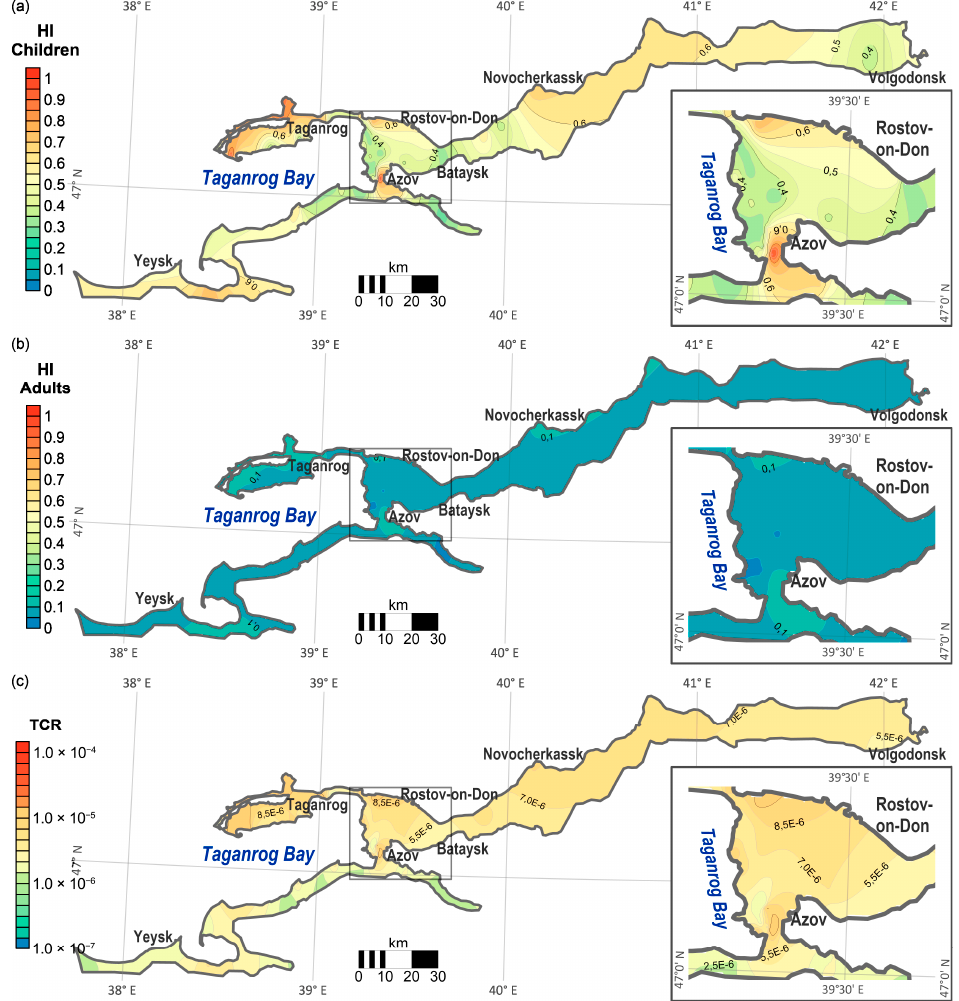
Figure 6. Spatial distribution of human health risk indices for PTEs and PAHs in topsoils of the Lower Don floodplain and the Taganrog Bay coast: ( a ) Total hazard index for children (HI_Children); ( b ) Total hazard index for adults (HI_Adults); and ( c ) Total carcinogenic risk ( TCR ).